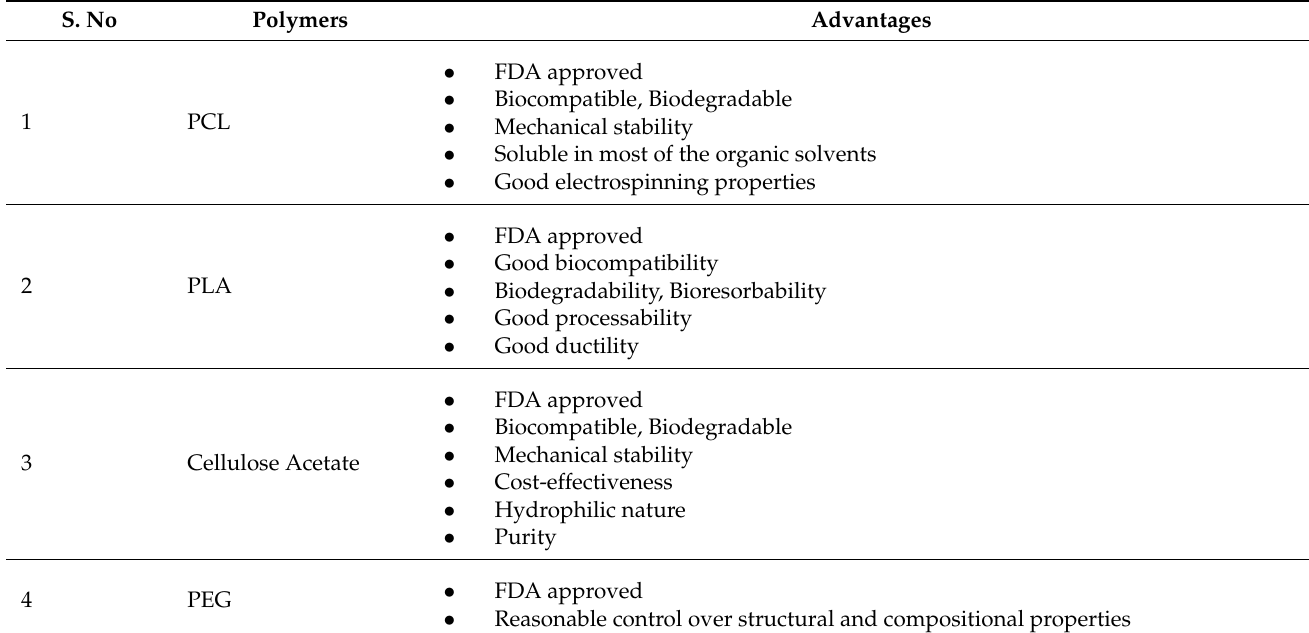
Table 5. List of FDA approved polymers used in the formation of Electrospun